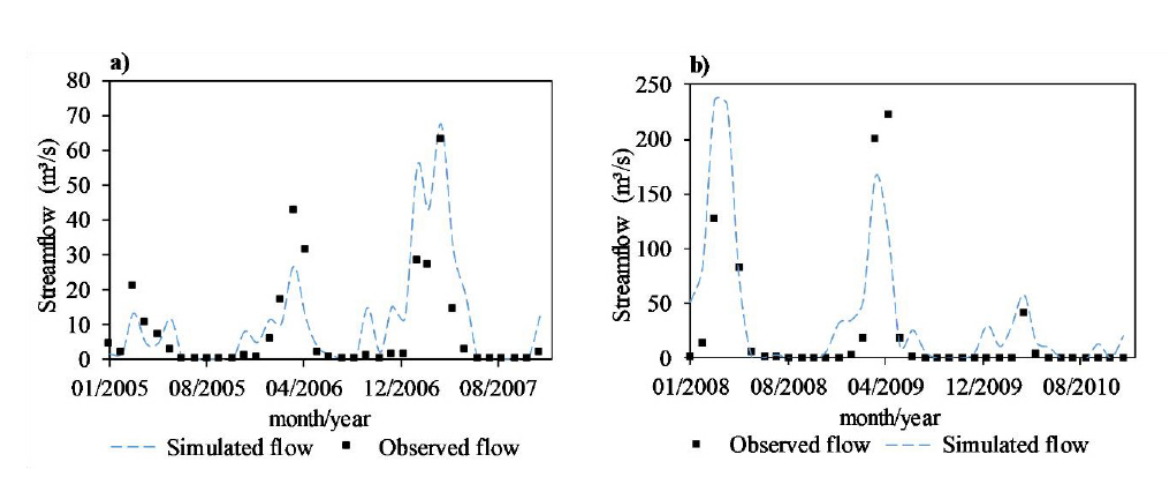
Figure 2. Calibration (2005-2007) (a) and validation (2008-2010) (b) of the SMAP model for the Orós